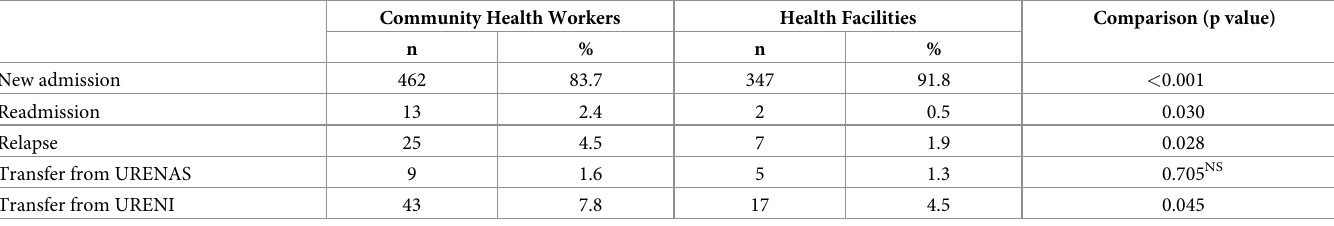
Table 1. Distribution of children according to the reason for admission by each model of outpatient treatment.